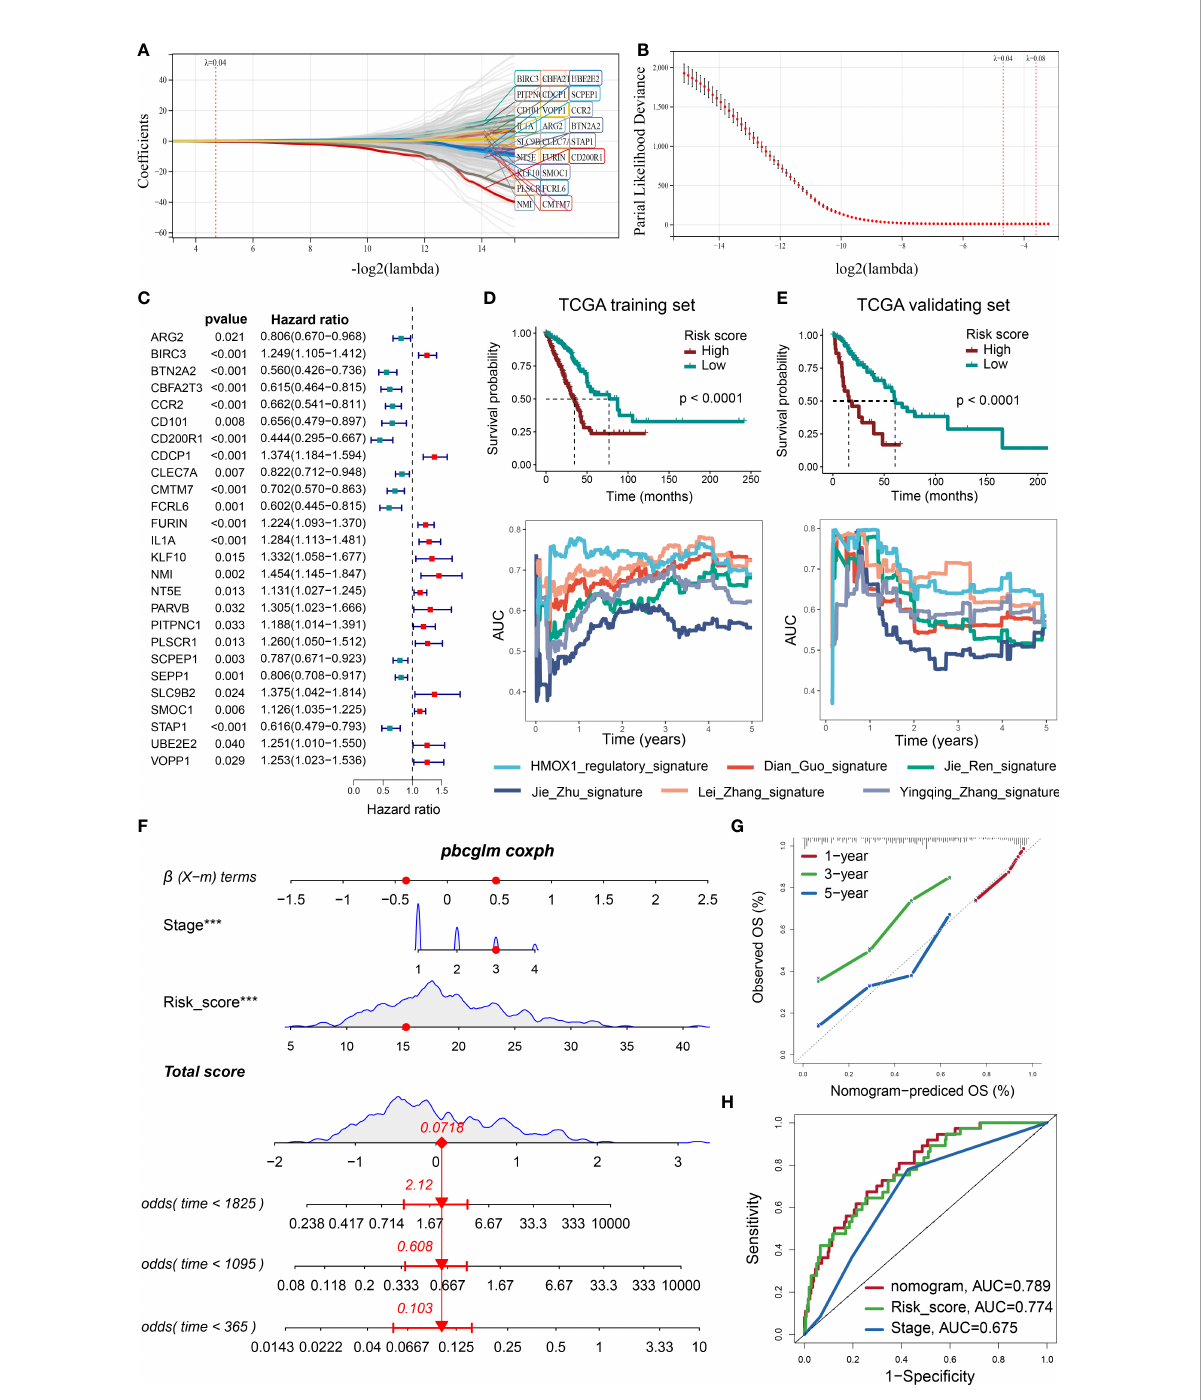
FIGURE 8 Developing a prognosis prediction model using the LASSO COX regression. (A) LASSO coef fi cient pro fi les of 307 prognosis-related genes, which were selected from the HMOX1-mediated metastasis regulatory network and its neighbor genes. (B) Cross-validation for tuning parameter screening in the LASSO regression model. Optimal genes with the best discriminative capability (26 in number) were selected for developing the risk scores. (C) Forest plot of the risk score gene-expression pro fi les in univariate analysis. (D) Development of risk score in the TCGA training cohort and its predictive accuracy for survival in comparison to additional 5 signatures. (E) validation of risk score in the TCGA validating cohort. (F) A nomogram integrating pathological stage, risk score, and OS probability in the TCGA training cohort. (G) Calibration plots showing the correlation between actual and predicted OS rates in the TCGA training cohort. (H) ROC curve plot evaluating the nomogram model, risk score, and pathological stage in the TCGA training cohort ***P <